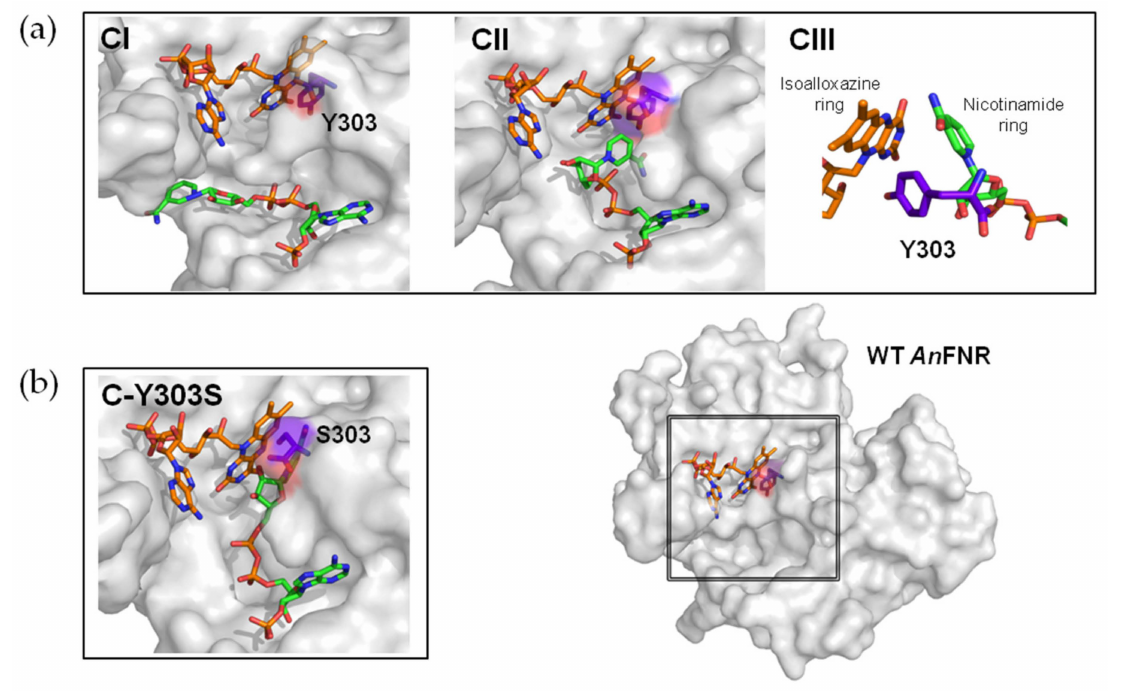
Figure 1. Proposed steps for the interaction of NADP + with AnFNR to attain a catalytically competent complex as depicted by available structural models. ( a ) Detail of the FNR active site in three models of ternary complexes. C-I and C-II are crystallographic models for FNR ox :NADP + complex (PDBs 1quf and 1gjr, respectively) related with the initial recognition and binding of the 2-P-AMP moiety, and the subsequent binding of the pyrophosphate moiety of the coenzyme NADP + . In none of these structures, the nicotinamide redox moiety of the coenzyme attaches a catalytically competent association to the flavin isoalloxazine ring, because the C-terminal Y303 stacks against the isoalloxazine. C-III shows the organization at the active site of a computationally optimized model that allows stacking of the coenzyme nicotinamide to the isoalloxazine, compatible with HT, and where Tyr303 contributes to nicotinamide allocation [27,30]. ( b ) C-Y303S stands for the crystal structure of the Y303S FNR ox :NADP + crystallographic complex (PDB 2bsa), where strong isoalloxazine–nicotinamide stacking prevents the photosynthetic HT [29]. FAD and NADP + are represented in CPK sticks with carbons colored in orange and green, respectively. The C-terminal residue (Y303 or S303) is shown in CPK with carbons in violet purple. The bottom panel on the right shows the corresponding structure of WT AnFNR (PDB 1que), where the studied region in the rest of the panels is highlighted inside a